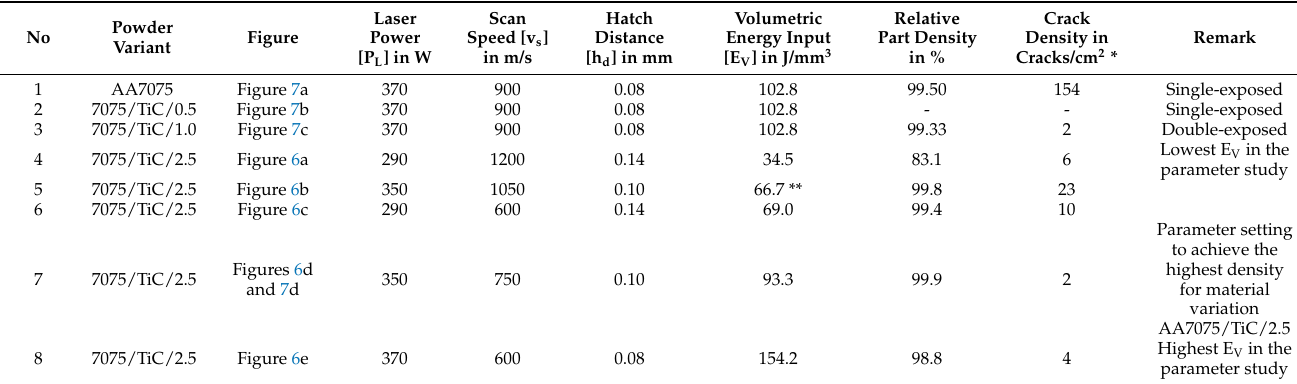
Table 4. Resulting crack density and part density for various powder variants and different process parameter settings of